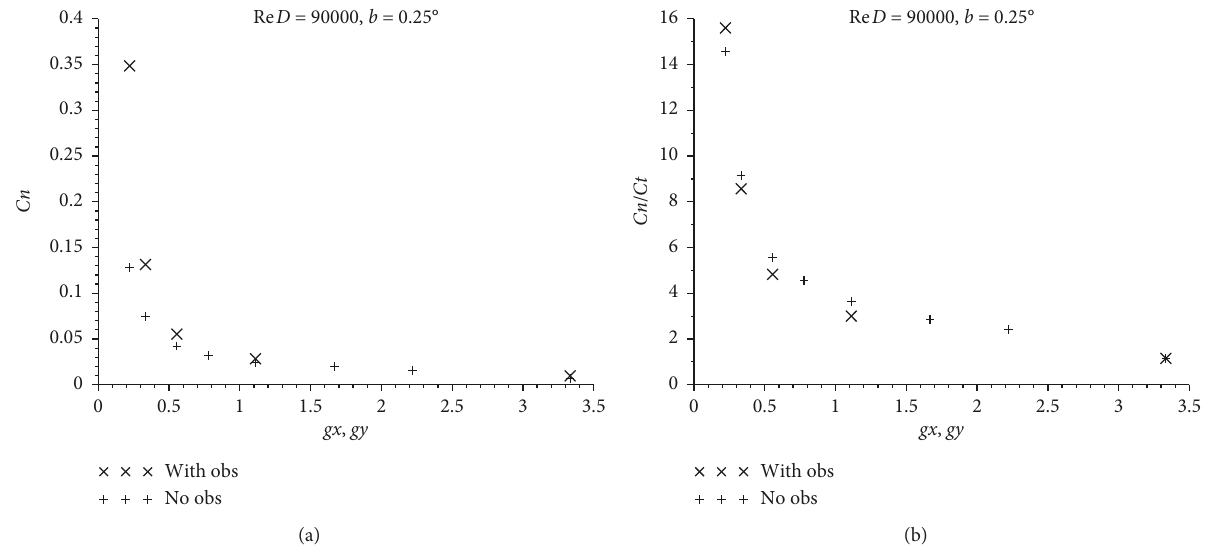
Figure 12: Evolution of Cn as a function ofthe angle b for a small confinement, comparison with and without small obstacle ( l � 1.1 and e �